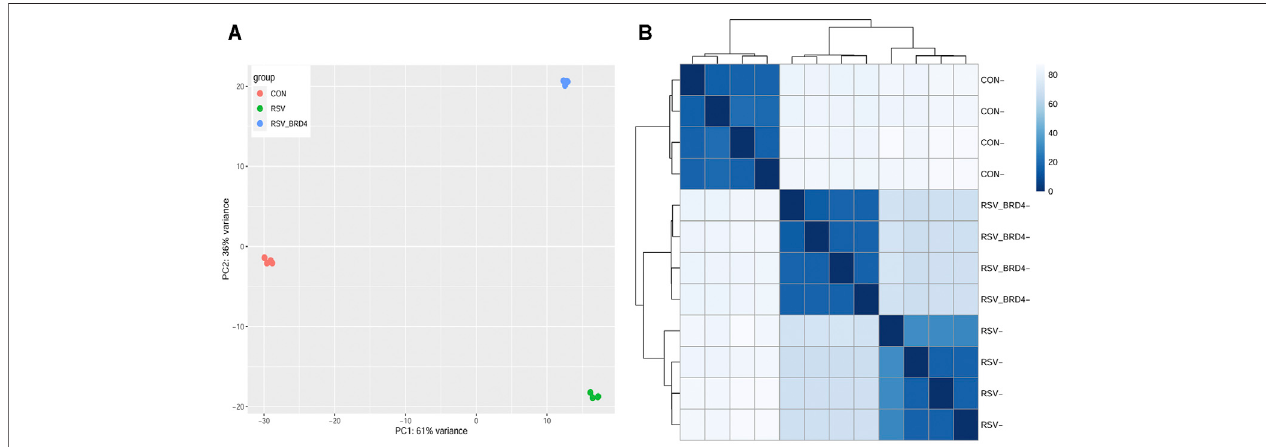
FIGURE 2 | Sample QC. (A) Principal component analysis. X axis, fi rst principal component; Y axis, second principal component. Note that the fi rst principal component separates the RSV ( ± BRD4 inhibitor) from the CON-treated samples and represents 61% of the variability in the experiment. The second dimension separates the RSV vs RSV + BRD4 inhibitor treatment. (B) Correlation analysis of log-transformed RNA-Seq quantitation of the experimental samples. Samples were subjected to hierarchical clustering, with distance indicated in the dendrogram. Note that the individual CON, RSV-BRD4 inhibitor, and RSV-infected samples cluster with other replicates receiving the sample treatment and separate from other